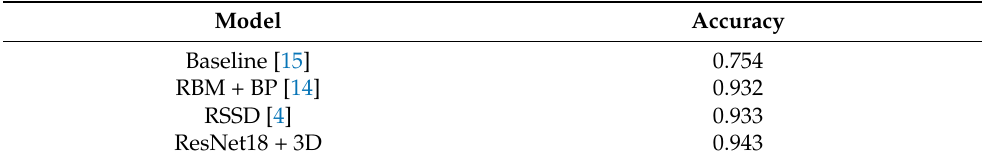
Table 5. The comparison of recognition accuracy with other models on ShipsEar.